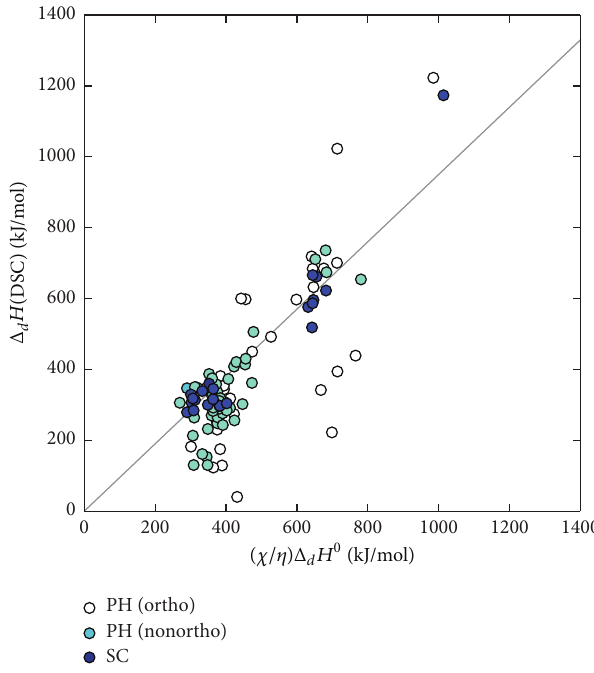
Figure 3: Observed DSC decomposition enthalpies as a function of the descriptor employed in